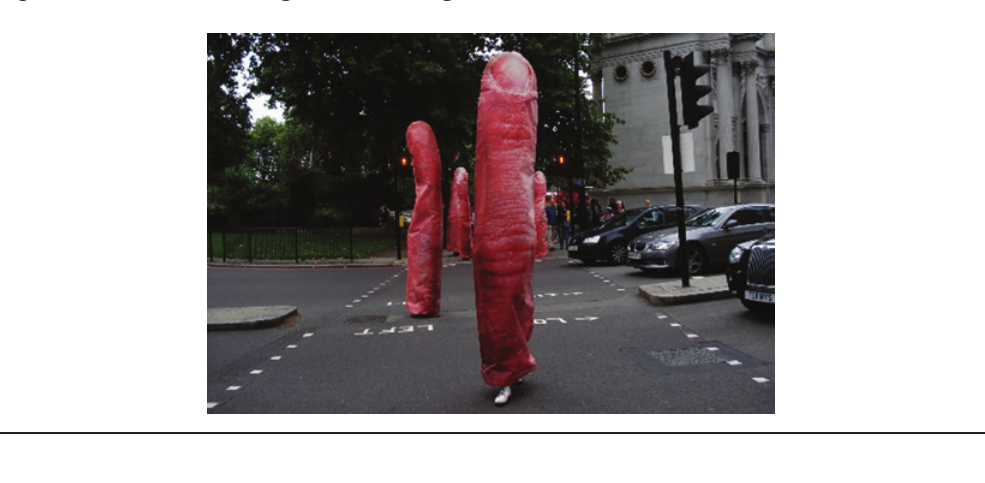
figure 1: Natasha Rosling, Field of Fingers , 2011–12